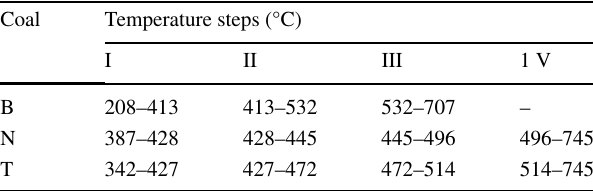
Table 6 The temperature ranges for the coal pyrolysis